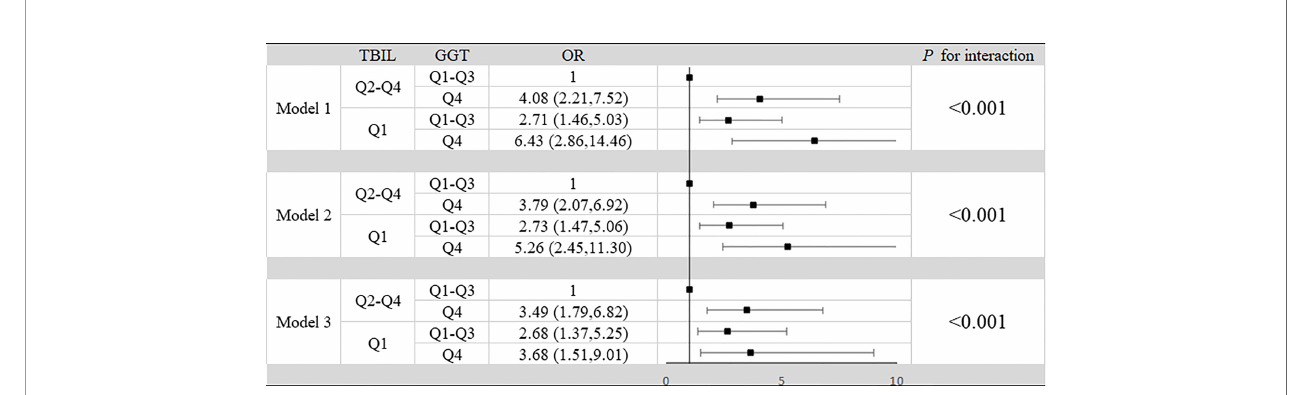
FIGURE 2 | Interaction between TBIL and GGT in aggravation of SLE in patients. Model 1: unadjusted. Model 2: adjusted for age, BMI, smoking status, alcohol consumption and estrogen level. Model 3: adjusted for age, BMI, smoking status, alcohol consumption, estrogen level, ALT, AST, SUA, CRP, IL-2, IL-4, IL-6, IL-10, TNF- a , hypertension, hyperlipidemia and diabetes mellitus.